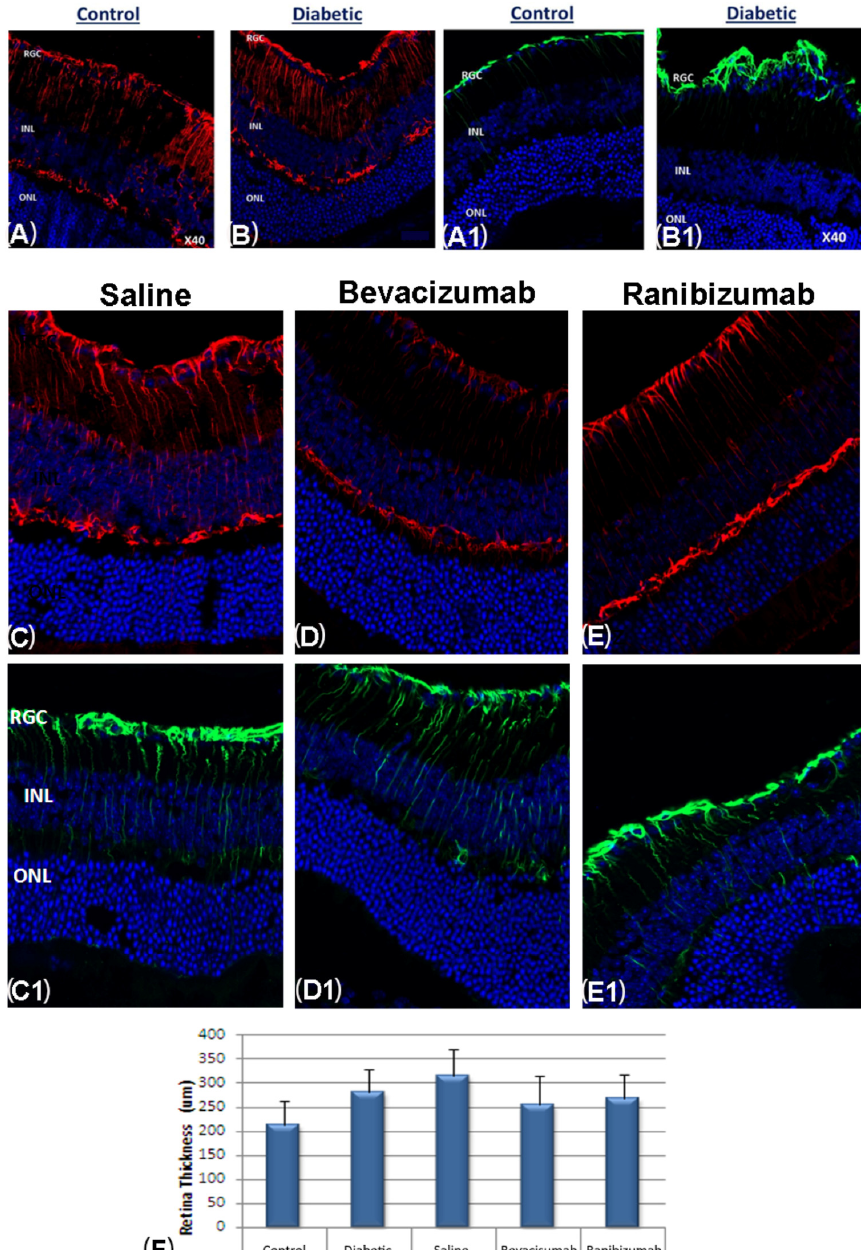
Müller cells in the retina of all DMT1 mice (28 STZ-NOD) compared to the non-diabetic NOD mice (n = 7) (Figure 6A,B) but not in DMT2 mice.